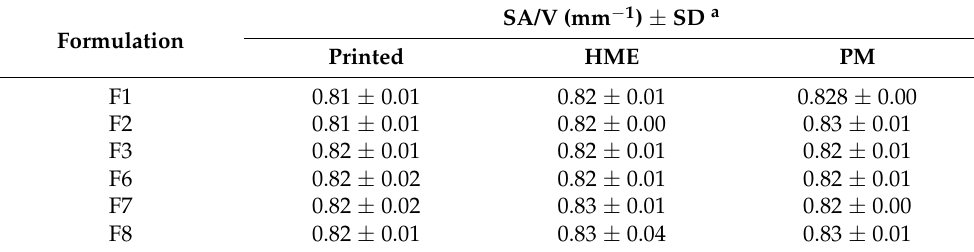
Table 4. SA/V values of tablets made via different